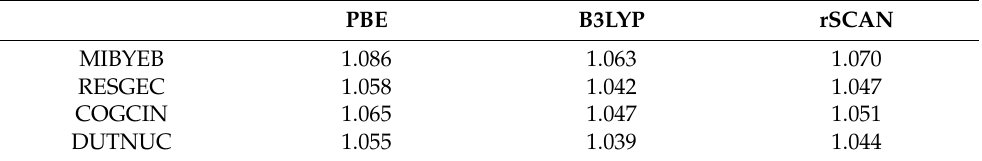
Table 1. The N1–H1 distances (Å) in the pyrimidium species obtained after the geometry optimization of the crystal structures with the PBE, B3LYP and rSCAN functionals and an energy cutoff of 600 eV. PBE B3LYP rSCAN MIBYEB 1.086 1.063 1.070 RESGEC 1.058 COGCIN